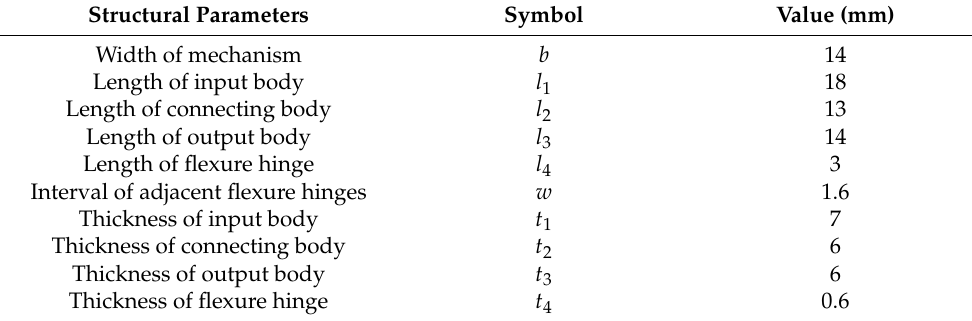
Table 1. The given structural parameters of the bridge-type amplification mechanism.